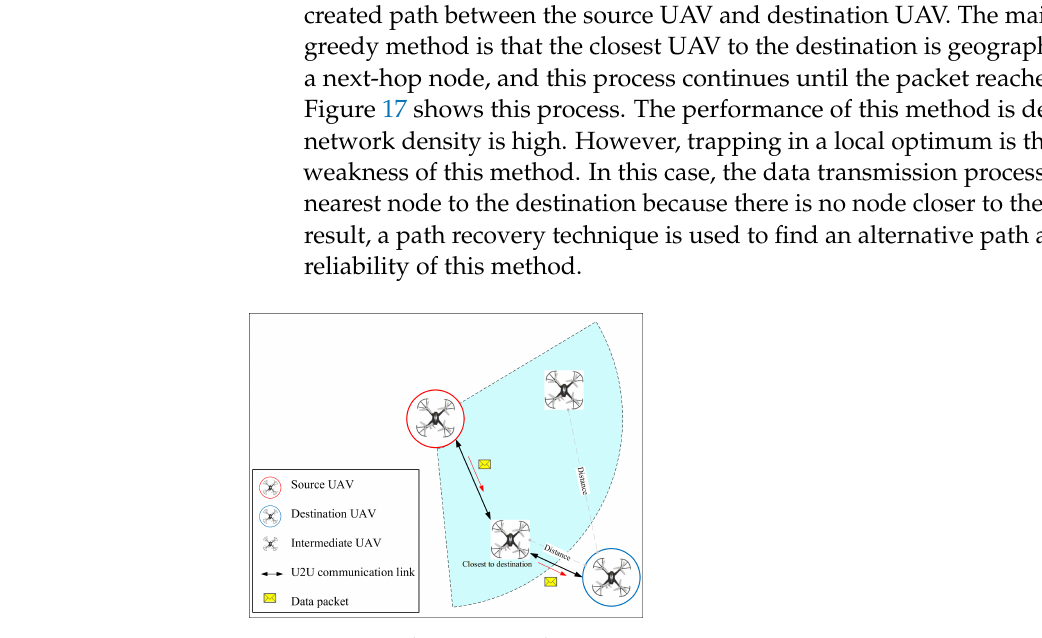
Figure 17. Greedy routing technique.